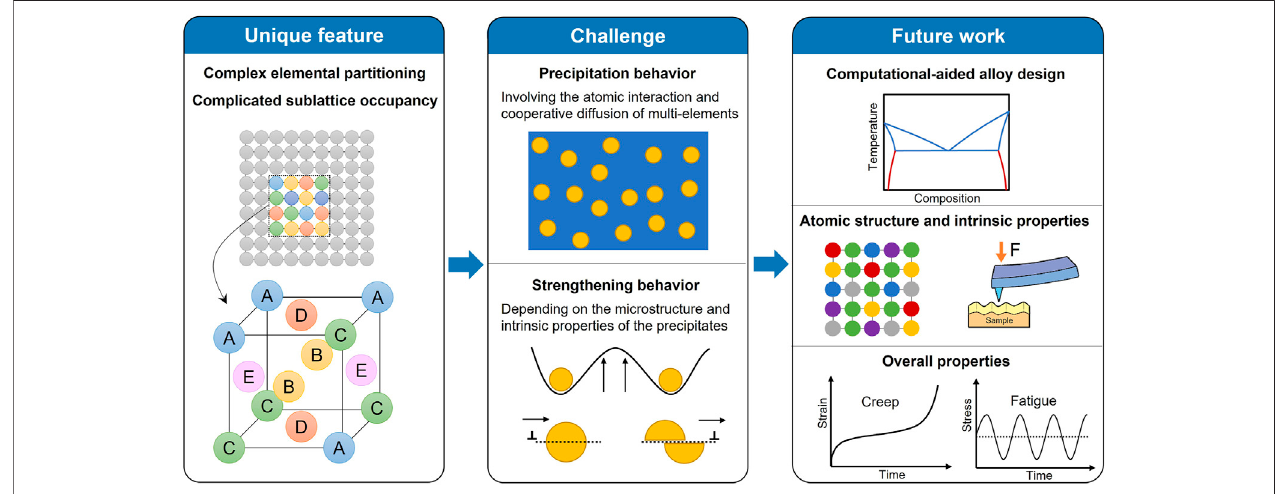
FIGURE 1 | Schematic summarizing the unique features, challenges, and future work of multicomponent-precipitation-strengthened alloys.